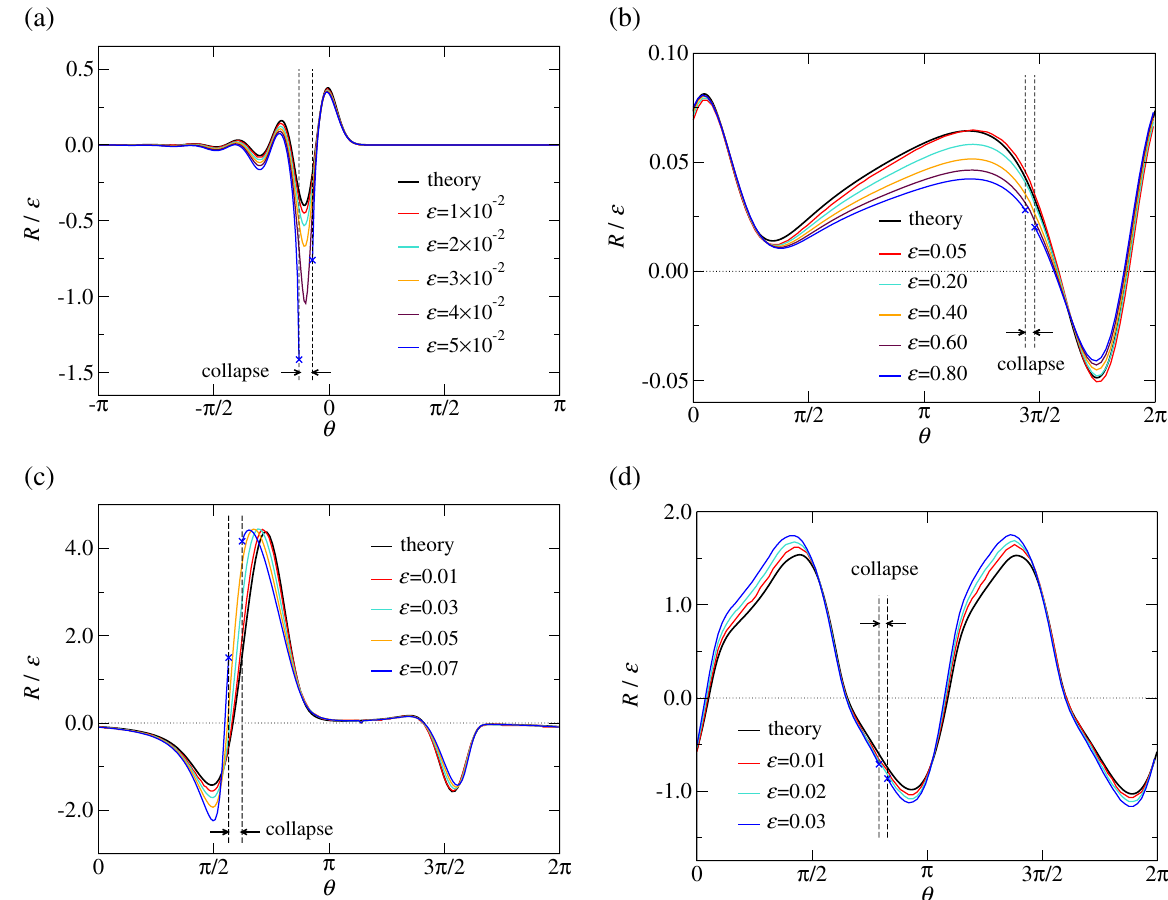
FIG. 9. Phase-response curves of four types of rhythmic spatiotemporal patterns to strong perturbations obtained by direct numerical simulations. Parameters and stimulation patterns are described in Figs. 1 – 4. (a) Circulating pulse. A bell-shaped perturbation is given to the activator ( u ) component. When ε ¼ 5 × 10 − 2 , the circulating pulse collapses and the phase response becomes undefined in the interval indicated in the figure. (b) Oscillating spot. A bell-shaped perturbation is given to the activator ( u ) component. When ε ¼ 0 . 8 , the oscillating spot collapses. (c) Target wave. A sinusoidal perturbation is given to the activator ( u ) component. When ε ¼ 0 . 07 , the target wave collapses. (d) Rotating spiral. The checkerboard-like perturbation is given to the activator ( u ) component. When ε ¼ 0 . 03 , the spiral